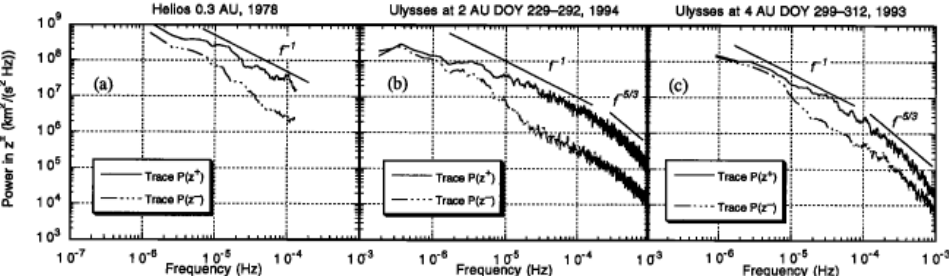
Figure 2. Reproduction of a figure (Figure 1) of the article by Goldstein et al. (1995) [13]: the spectra of Z + and Z − are plotted at heliocentric distances r = 0.3 AU ( panel a ), r = 2 AU ( panel b ) and r = 4 AU ( panel c ). Courtesy of John Wiley and Sons. Permission to reprint